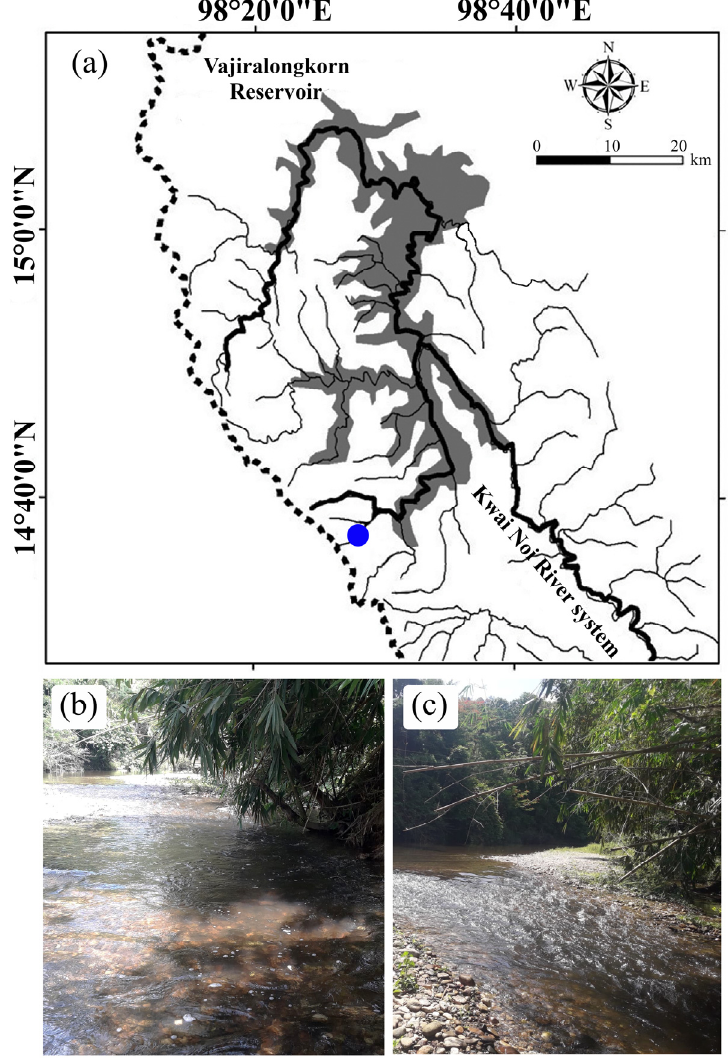
Figure 1. Map of the study area ( a ), indicating the sampling location (blue dot) in Pakkok River, Kwai Noi River system, Mae Khlong basin, Thong Pha Phum, Kanchanaburi province, Thailand. The habitat of the Pakkok River observed from the same vantage point during the wet season of 2017 ( b ) and the dry season of 2017 ( c ). Table 1. Physiochemical parameters of Pakkok River, Kwai Noi River system, Mae Khlong basin, Kanchanaburi province, Thailand during the wet and dry seasons of 2017 and 2022.